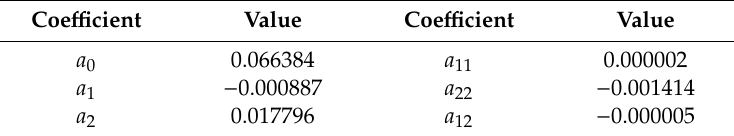
Table 2. Coe ffi cients of the CFL correlation.